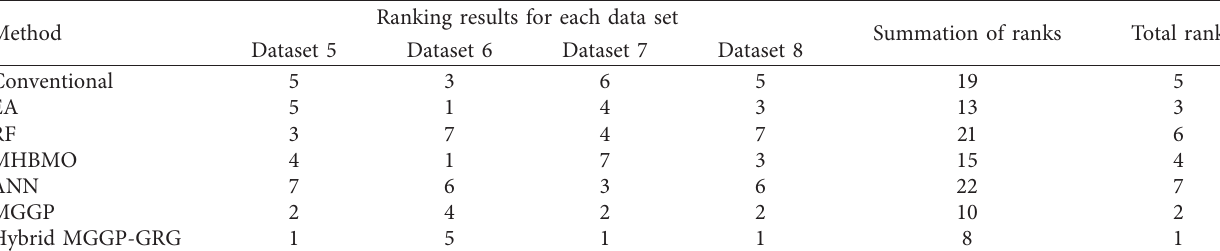
Table 7: Ranking the performances of different methods for developing loop rating curves. Method